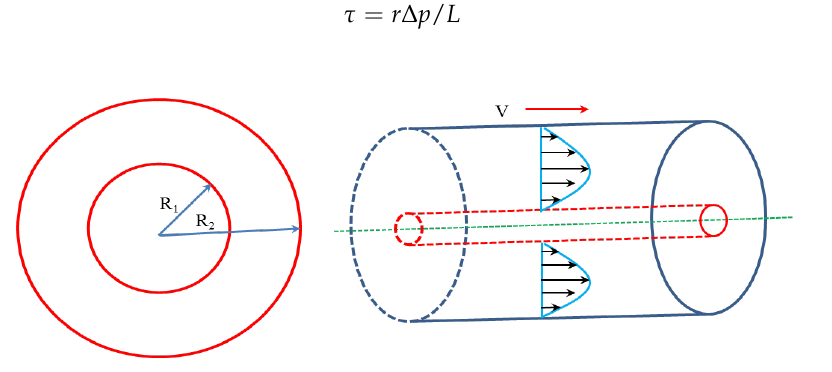
Figure 1. Velocity distribution of wellbore annulus.